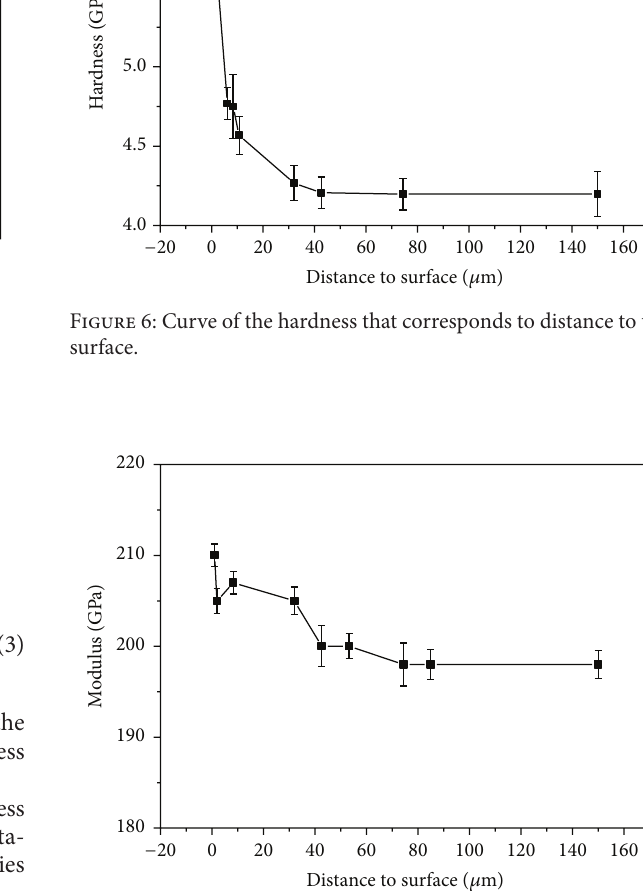
Figure 7: Curve of the elastic modulus that corresponds to distance to the